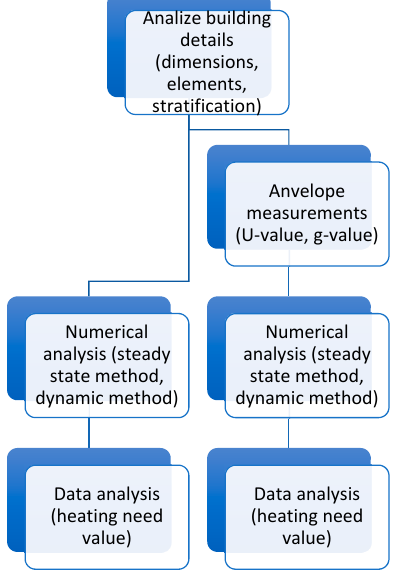
Figure 1. Methodological flowchart.